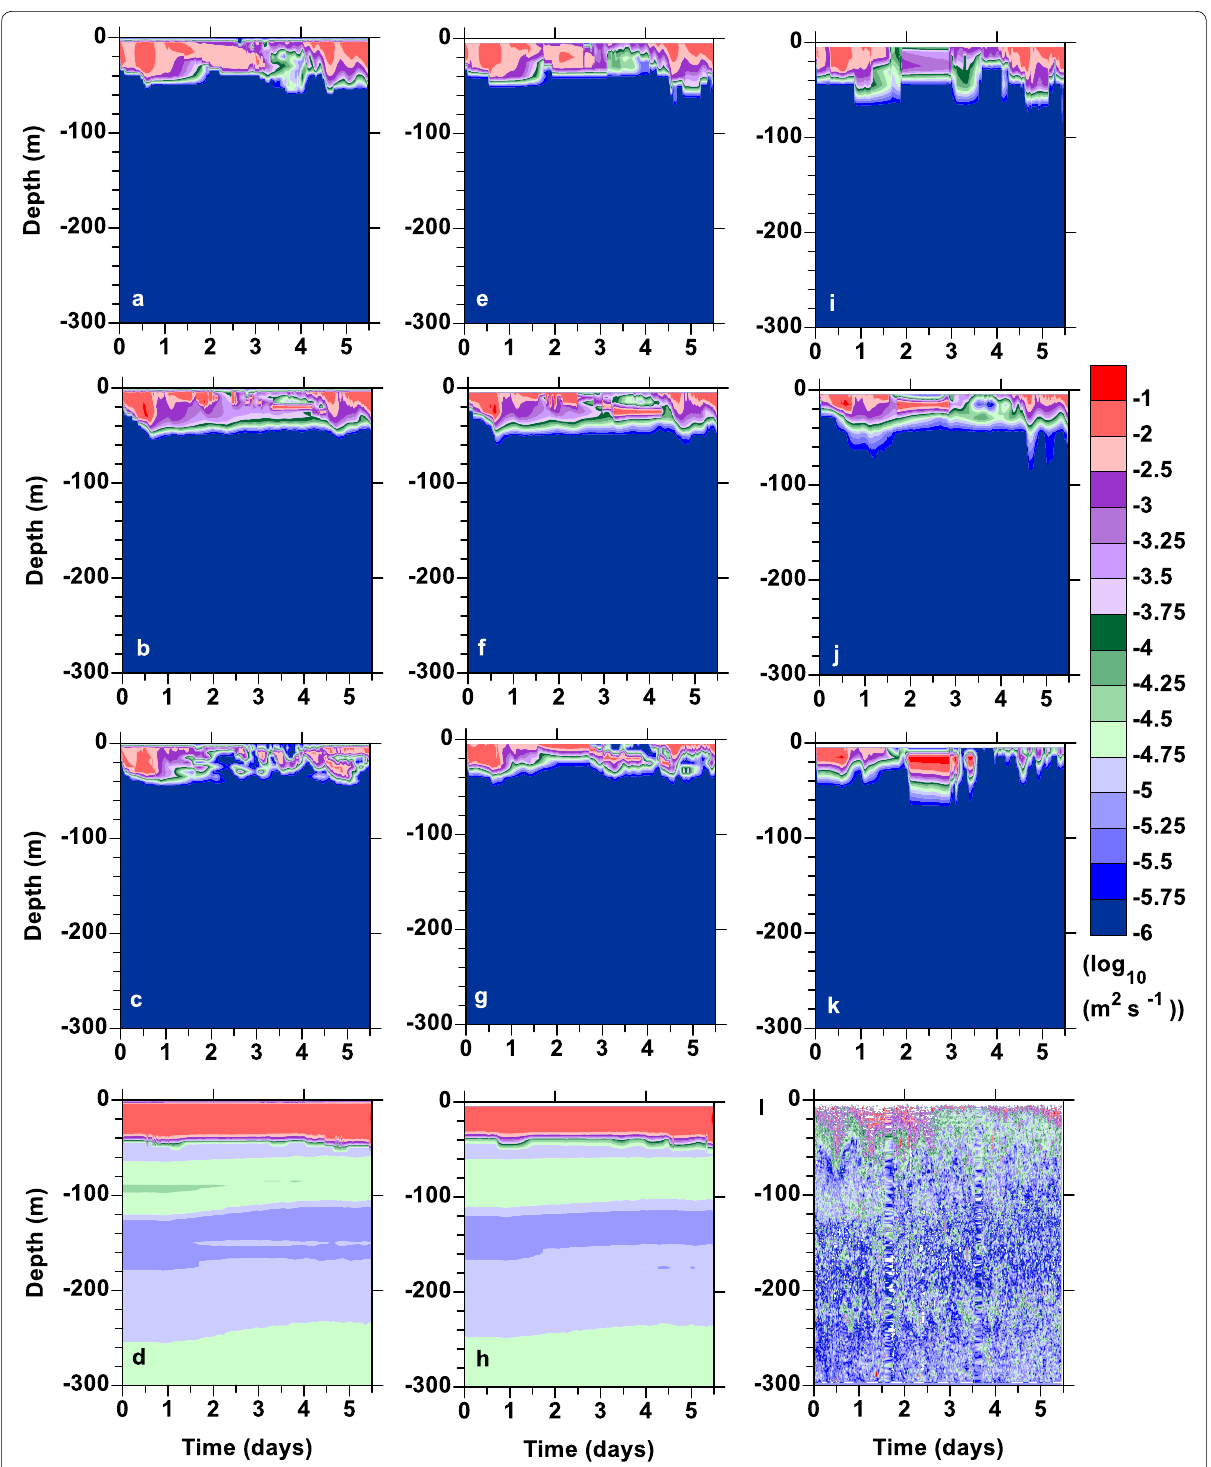
Fig. 3 Log 10 of the temperature diffusivities with depth during the FLX91 simulations ( a – k ) and the observations l. The simulations were done with ( a – d ) 100 levels, ( e – h ) 50 levels, and ( i – k ) 25 levels. The results from Nakanishi – Niino are given in ( a , e , i ), those from Mellor – Yamada 2.5 in ( b , f , j ), GLS in ( c , g , k ) and Large – McWilliams – Doney in ( d , h ). No results are shown for Large – McWilliams – Doney for 25 levels as they were essentially the same as those for 50